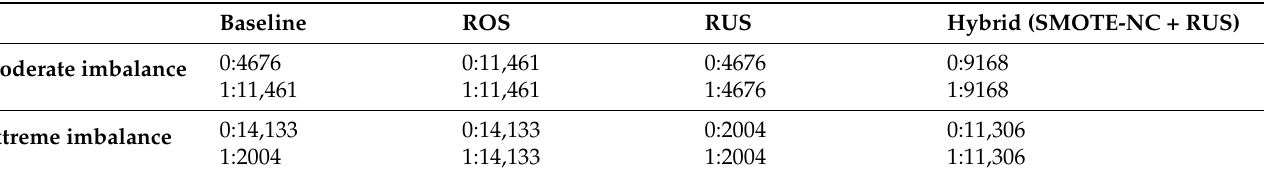
Table 2. Class sizes by datasets and resampling